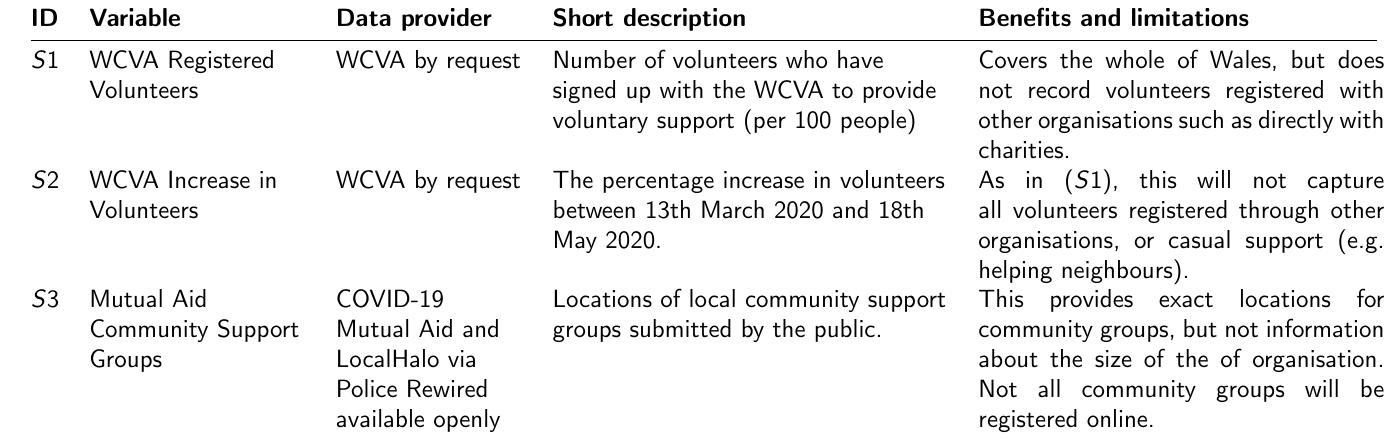
Table 4: Summary description of variables included in the support resources